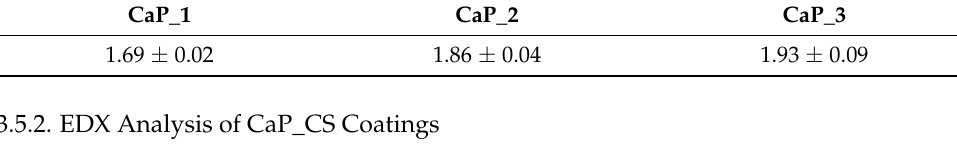
Table 5. EDX Ca/P ratios for the CaP coatings.